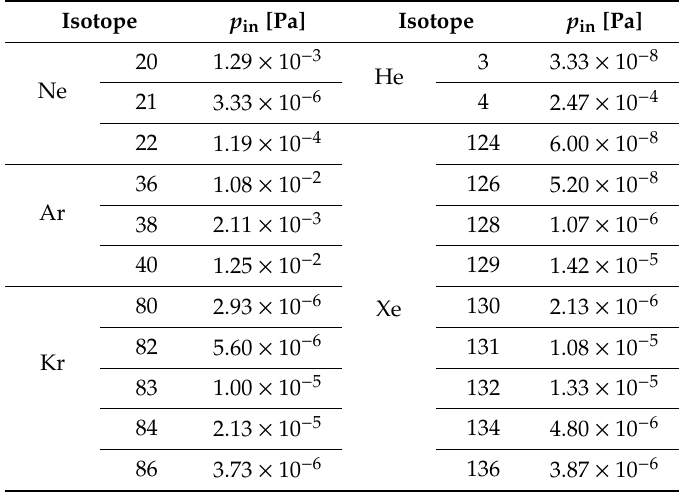
Table 2. Chemical model for the e ff ective (static + dynamic) inlet partial pressures p in of noble gases isotopes, as experienced by the sampling inlet at 110 km altitude and for probe velocity of ~10 km / s. Isotope p in [Pa]